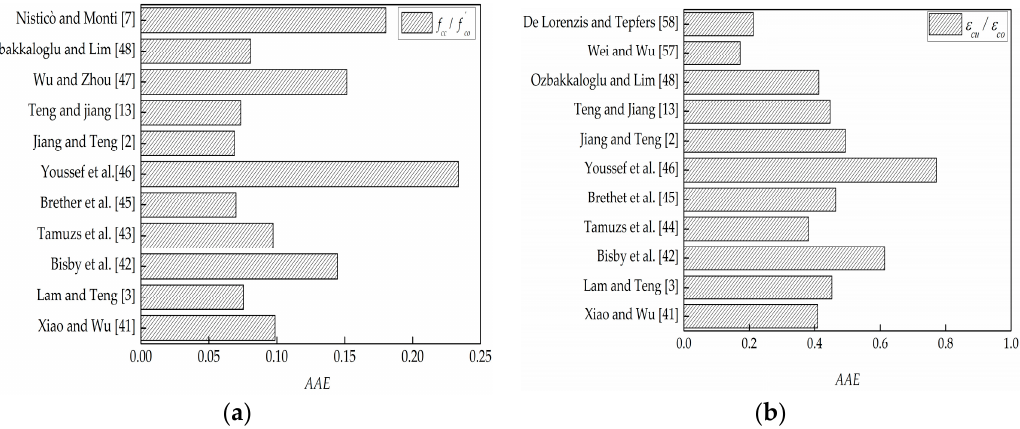
Figure 8. Models performance. ( a ) Ultimate strength models; ( b ) ultimate strain models. Table 9. Statistical assessment of the ultimate strength models.